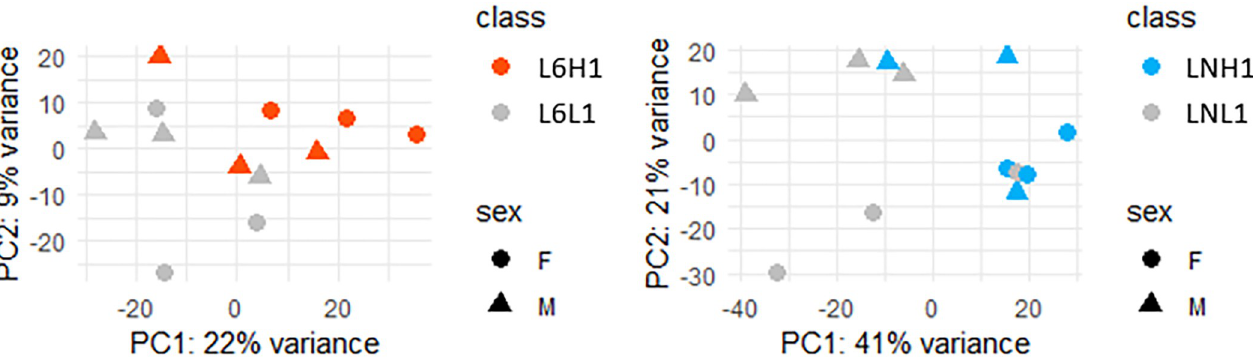
Fig 3. Principal component analysis of the gene expression in caecal tonsils from experiment 1 in each line. (A) Principal component analysis (PCA) of the gene expression in caecal tonsils within line 6 1 in experiment 1. (B) PCA of the gene expression in caecal tonsils within line N in experiment 1.